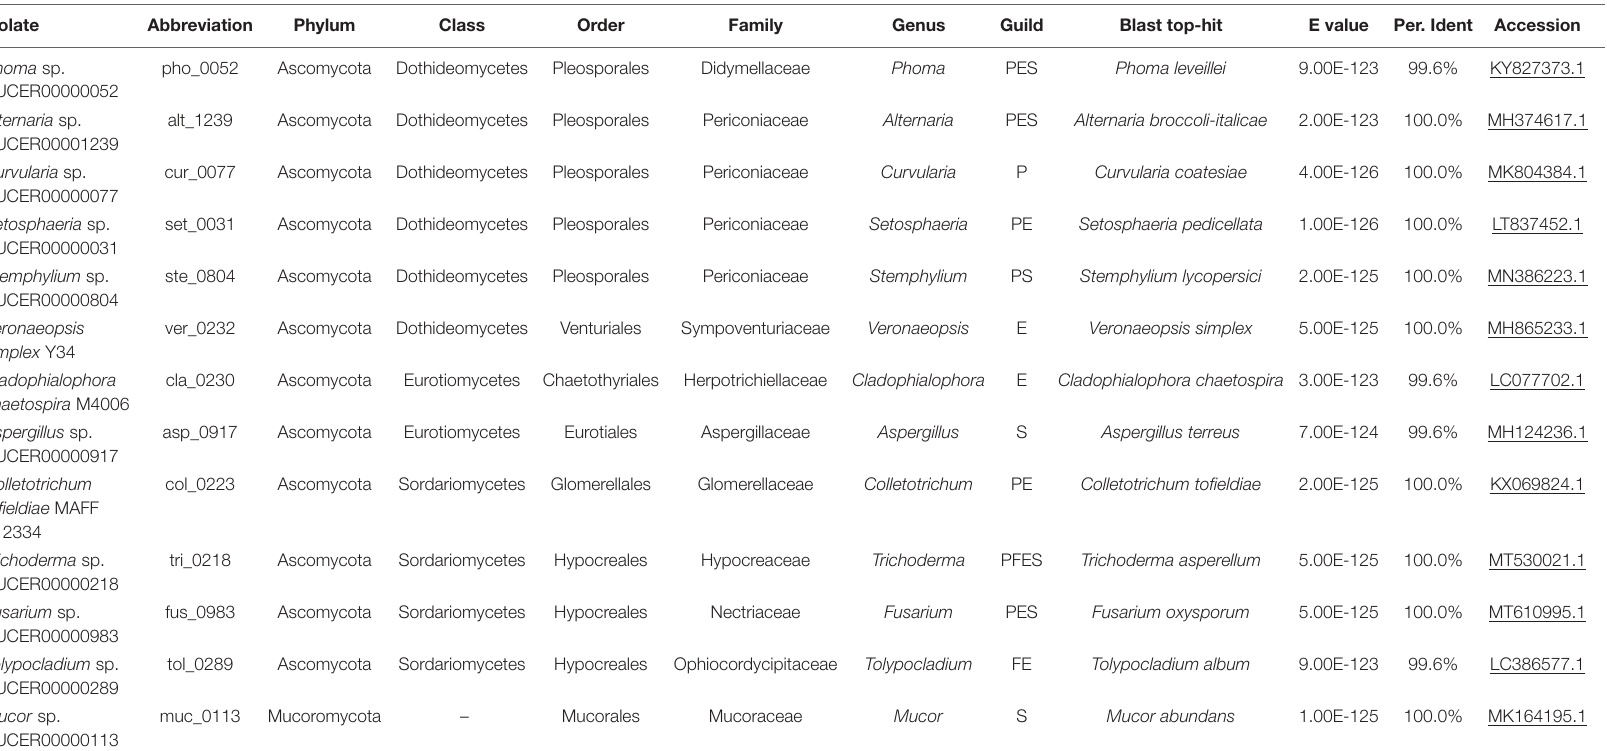
TABLE 1 | Summary of fungal isolates used in the inoculation experiments.